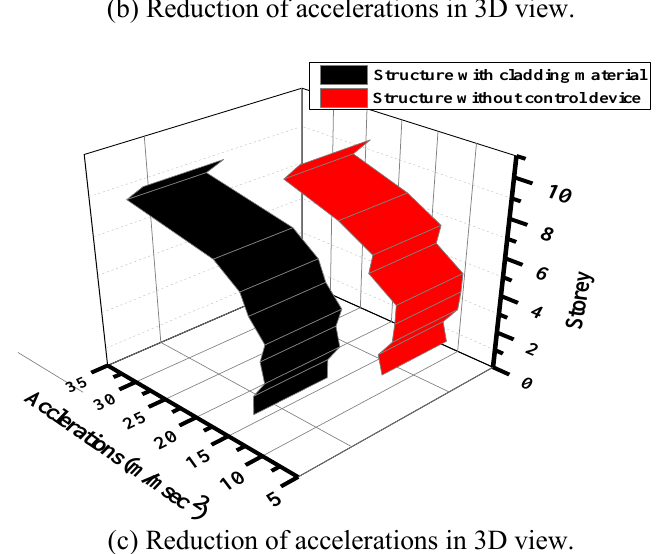
Fig. 8. Reduction of accelerations of a structural system by cladding